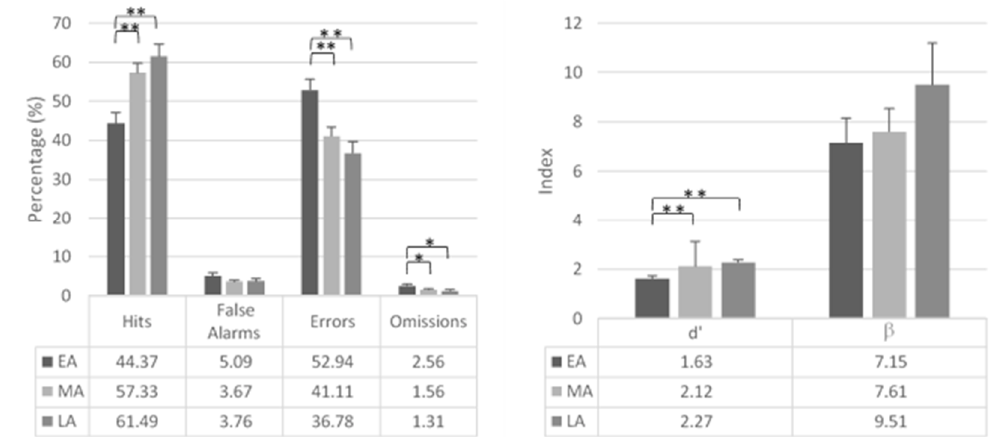
Figure 4. Mean vigilance indexes. ( Left ) Percentage of hits, false alarms, errors, and omissions. ( Right ) d ′ and β indexes. * p < 0.05; ** p < 0.01.